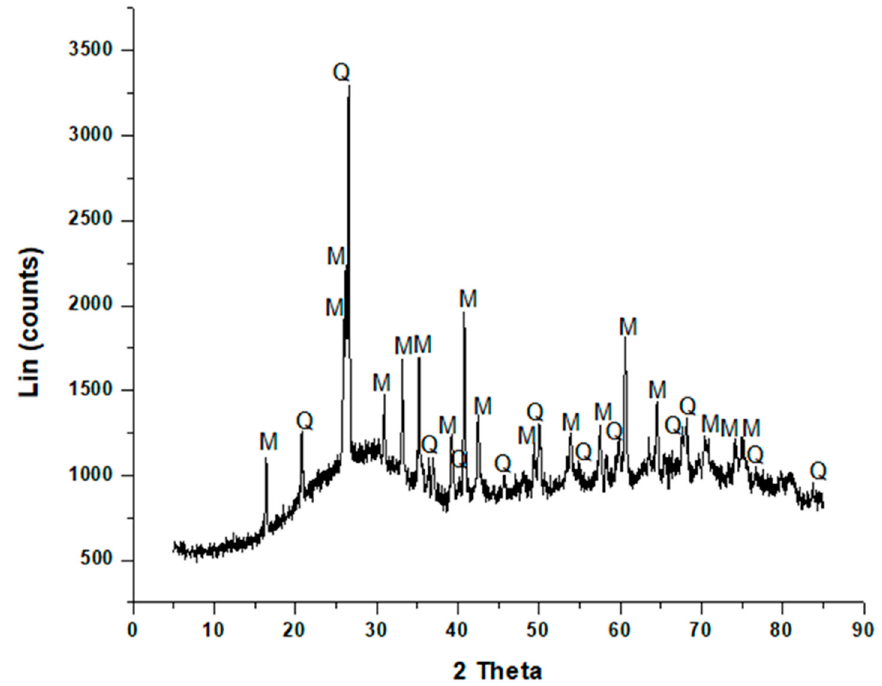
Figure 1. Qualitative XRD of coal fly ash. Q = quartz, M = mullite .